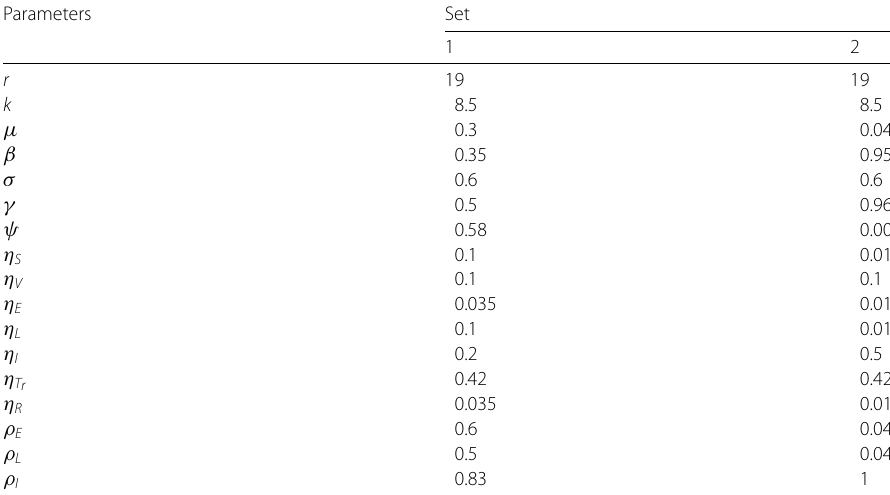
Table 2 Values of the parameters for SVELITR model (6) Parameters Set